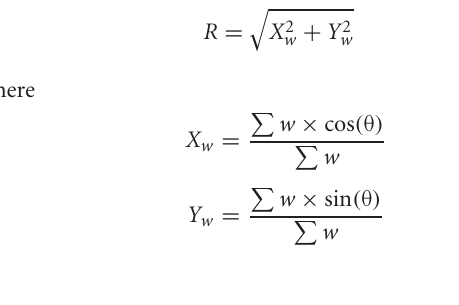
FIGURE 2 | Phase coherence of saline-treated and TMZ-treated rats to DG LFPs. (A) Sample LFP trace (mV) showing typical dentate spike (left) and theta rhythm (right) in DG. (B) Phase coherence calculated by weighting the contribution of each spike by the power of theta at the time of the spike. Upper: vectors of strength (magnitude) and preferred phase angles summarizing the phase coherence of all identified granule cells in saline-treated rats (left) and granule cells with significant phase relationships to local theta rhythm (right). Middle: vectors of strength and preferred phase